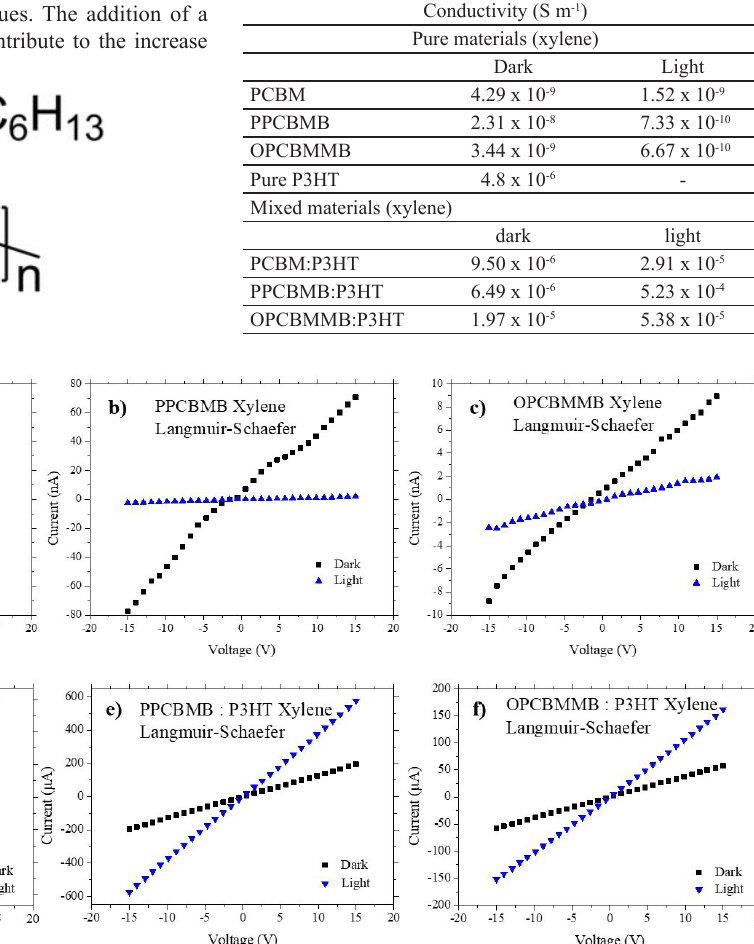
Figure 3. I vs V curves for pure and mixed films with poly(fullerene)s and P3HT, produced by the LS technique solubilized with xylene.